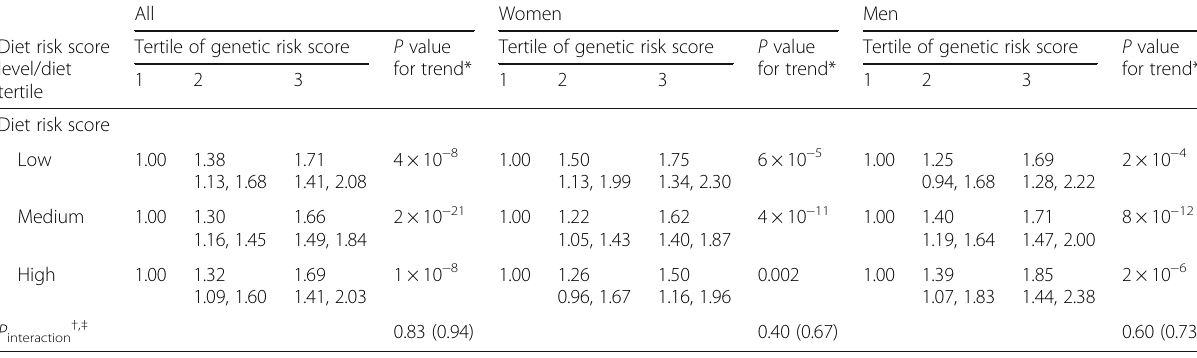
Table 3 Hazard ratios of incident type 2 diabetes according to a weighted genetic risk score in strata of a diet risk score based on intakes of processed meat, sugar-sweetened beverages (SSB), whole grain and coffee in 15,380 women and 9689 men from the Malmö Diet and Cancer